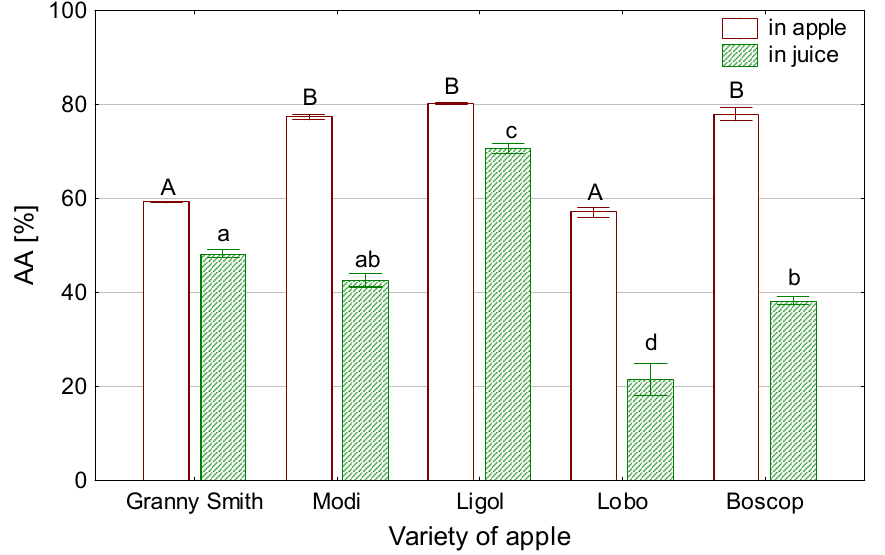
Figure 8. Influence of variety properties on antioxidant activity of juice and extracts from fresh apples. Different capital letters indicate values significantly different at p < 0.05 in apples. Different lowercase letters indicate values significantly different at p < 0.05 in juices.